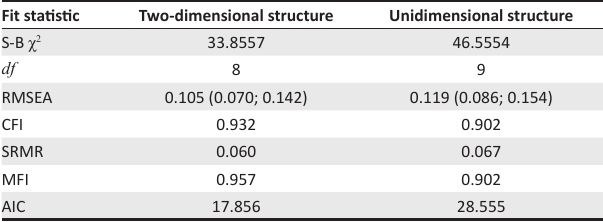
TABLE 3: Goodness-of-fit statistics of the hope construct (total